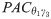
Mechanisms mediating indirect PAC connections (Case II).A) Three population toy model comprising three neuronal populations labelled as ‘1’, ‘2’, and ‘3’, oscillating in the theta (θ), beta (β), and gamma (γ) bands. B) PAC involving the phase of theta in population 1 and the amplitude of gamma in population 3 (PACθ1γ3) obtained when varying the connectivity parameters between populations 1 and 2 (Γ12 = 30:4:1000) and between populations 2 and 3 (Γ23 = 30:4:1000). Panels C to R, display the 16 predictors used in the ten models explored (Table 2). S) Coefficient of determination (R2) for the ten models explored (Table 2). T) Correlation coefficient between the 16 predictors.